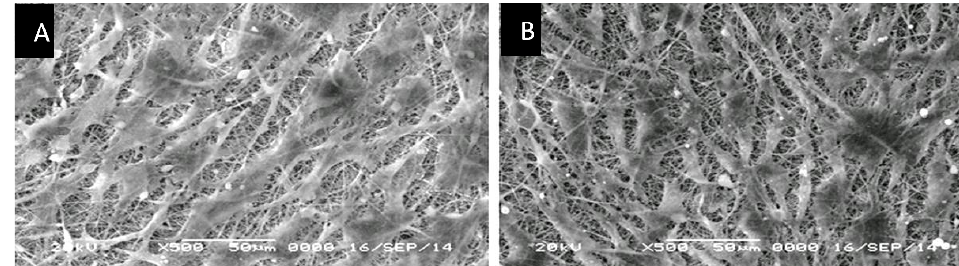
Figure 6. Scanning electron microscopy (SEM) images of MC3T3 after 24-h culture on Ctrl ePCL ( A ) and PA-ePCL treated with ethanol ( B ) show similar density and spreading behavior. This illustrates successful removal of PA residuals from ePCL by ethanol wash.